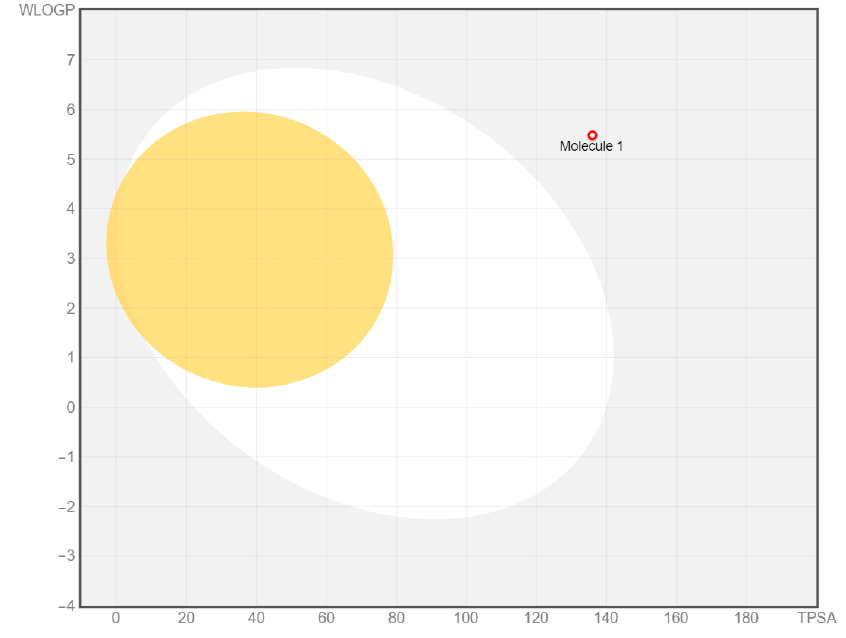
Figure 3. The bioavailability radar of chromeno[2,3- b ]pyridine ( 4 ).